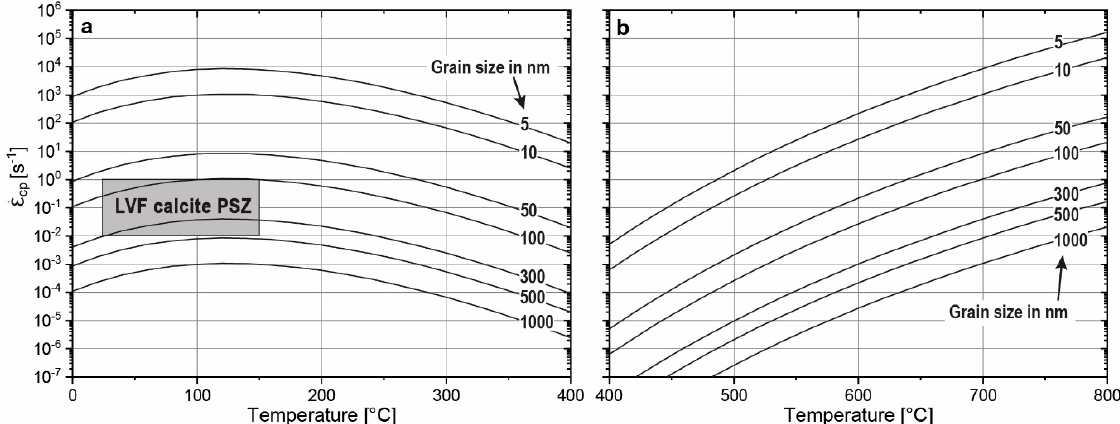
Figure 7. Intergranular compaction creep strain rates in granular calcite versus temperature for grain size d . ( a ). Water-assisted diffusive mass transfer. The grey shaded area indicates the conditions characterizing the PSZ developed in LVF experiments using simulated calcite gouge (Figures 4a,b and 6) [140] ( b ). Solid-state grain boundary diffusion. For a list of parameters used see Table 3.